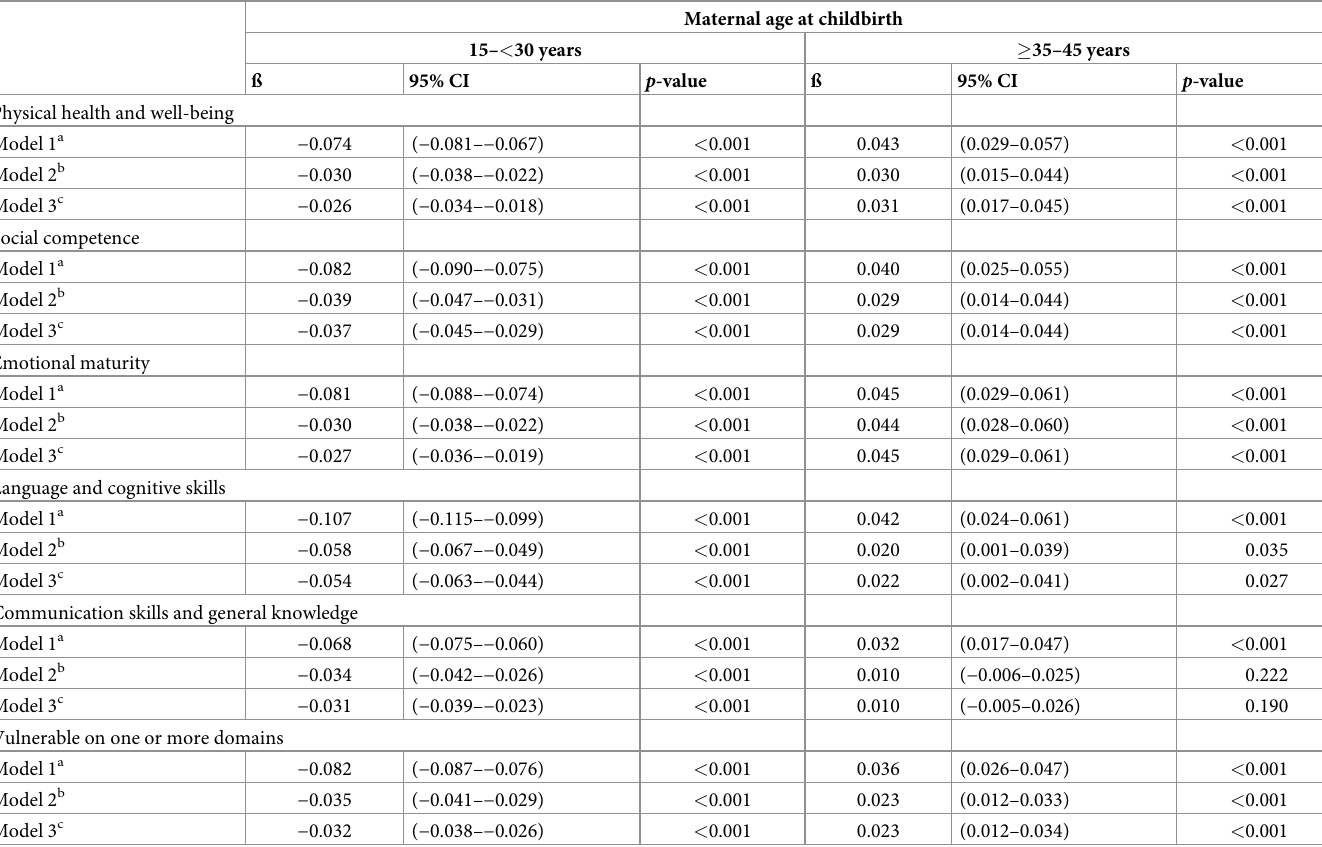
Table 2. Coefficients for 1-year increase in maternal age between 15– < 30 years, and (cid:21) 35–45 years, from piecewise linear regression